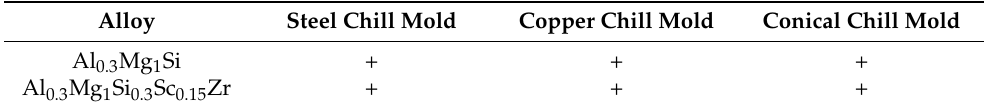
Table 1. Alloys and method of casting samples.